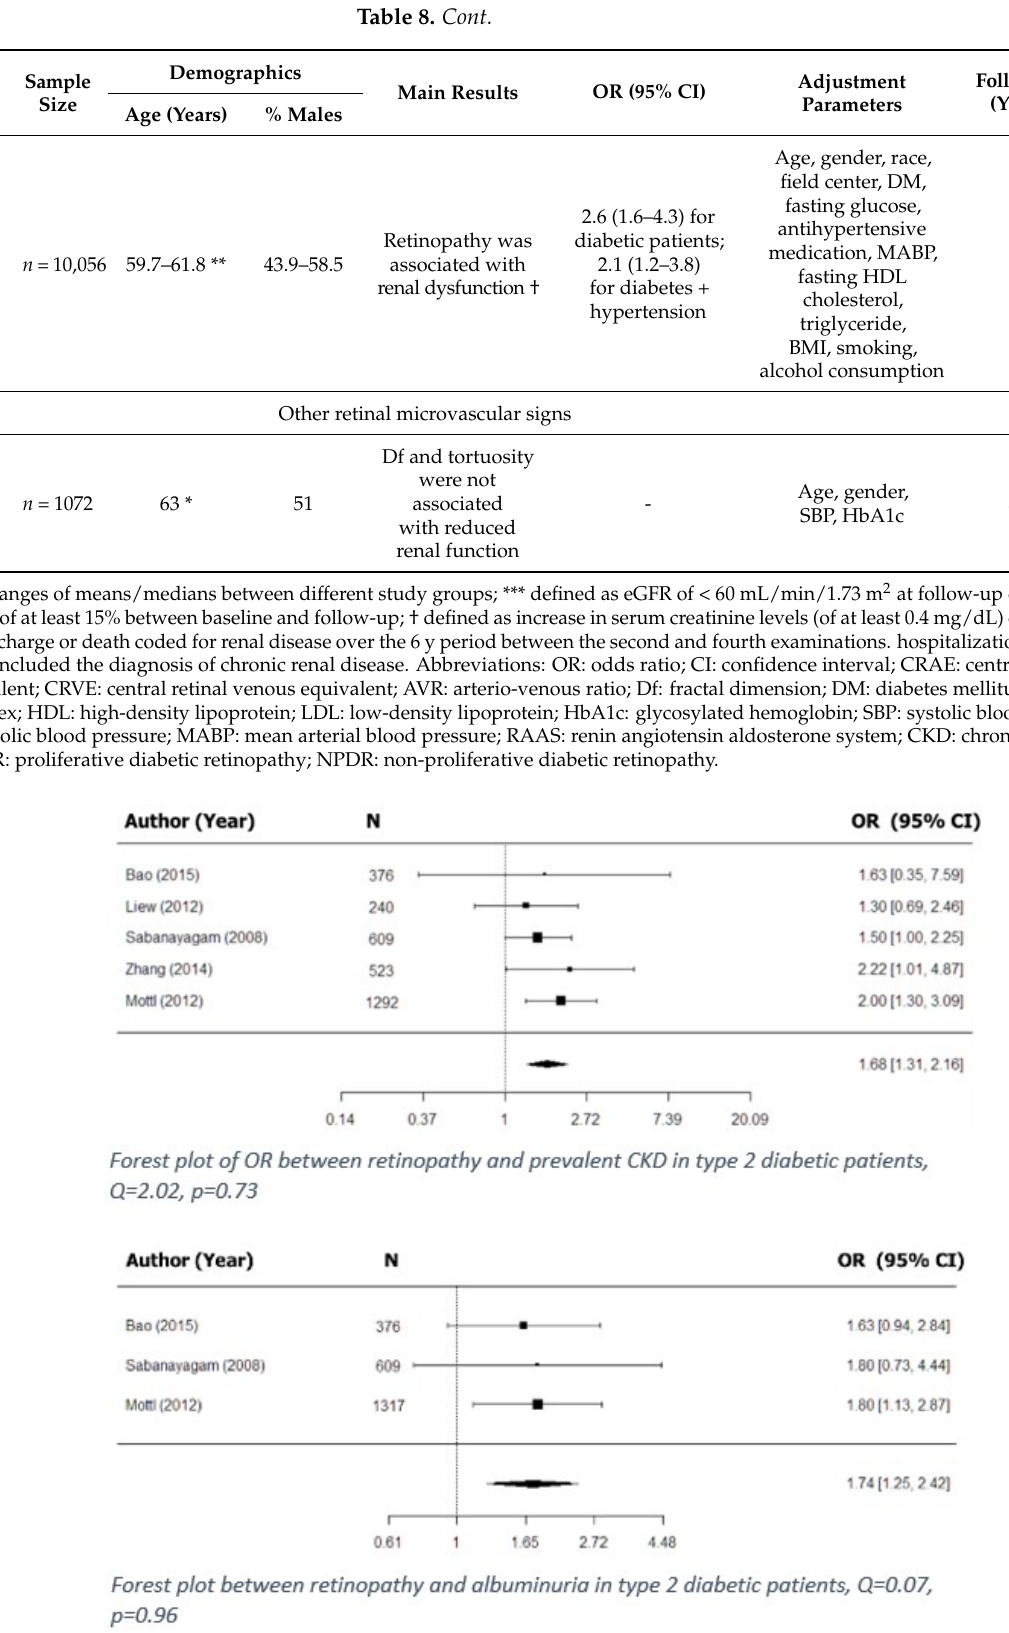
Figure 2. Cross-sectional associations between retinopathy and kidney dysfunction in type 2 diabetes.